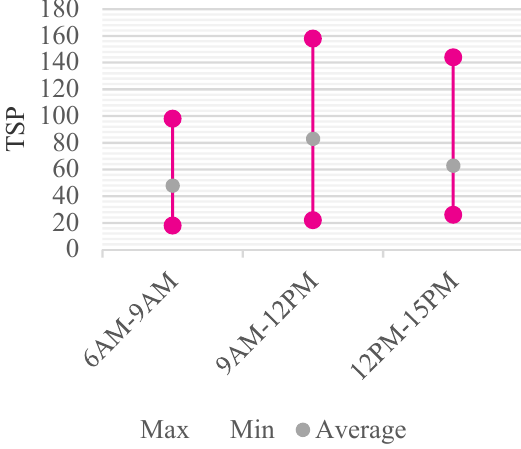
Figure 9. Daily concentration change of TSP.